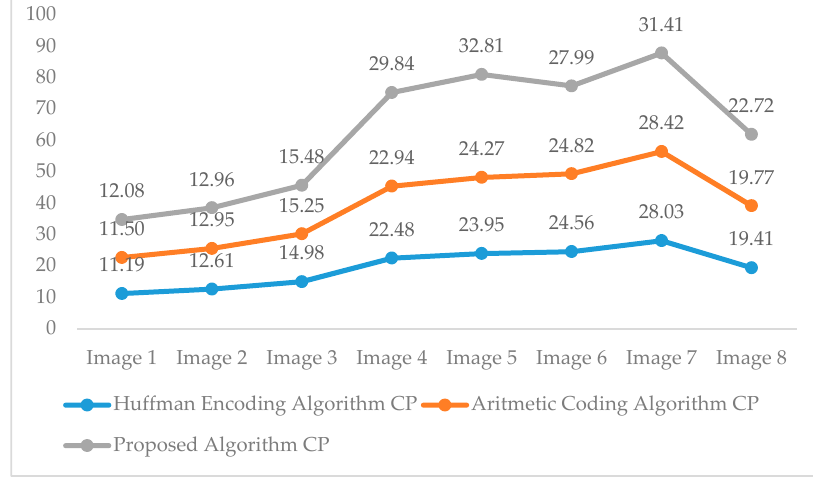
Figure 16. CP values of Group 3 images.